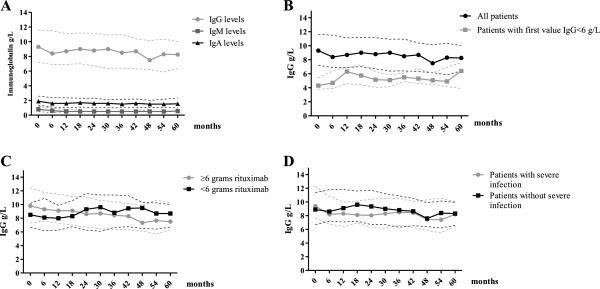
The effect of rituximab on median immunoglobulin levels. Median immunoglobulin levels are represented as a continuous line and interquartile ranges as dashed lines, according to time after first rituximab treatment, from 0 to 60 months. A. IgG, IgM and IgA levels for all 177 patients. B. Comparison of IgG levels for all patients with those patients with IgG <6 g/L before first rituximab (N = 18). C. Comparison of IgG levels for patients who received <6 g of rituximab in total (N = 79) and patients who received ≥6 g of rituximab (N = 98). D. Comparison of IgG levels for patients with (N = 71) and without (N = 106) severe infection.